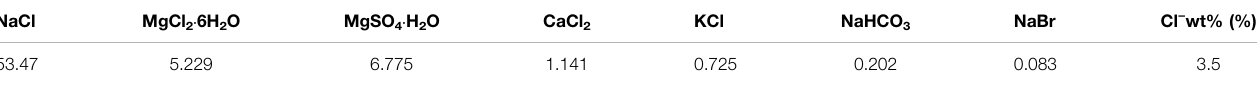
TABLE 2 | Arti fi cial seawater ingredients list (g/L).